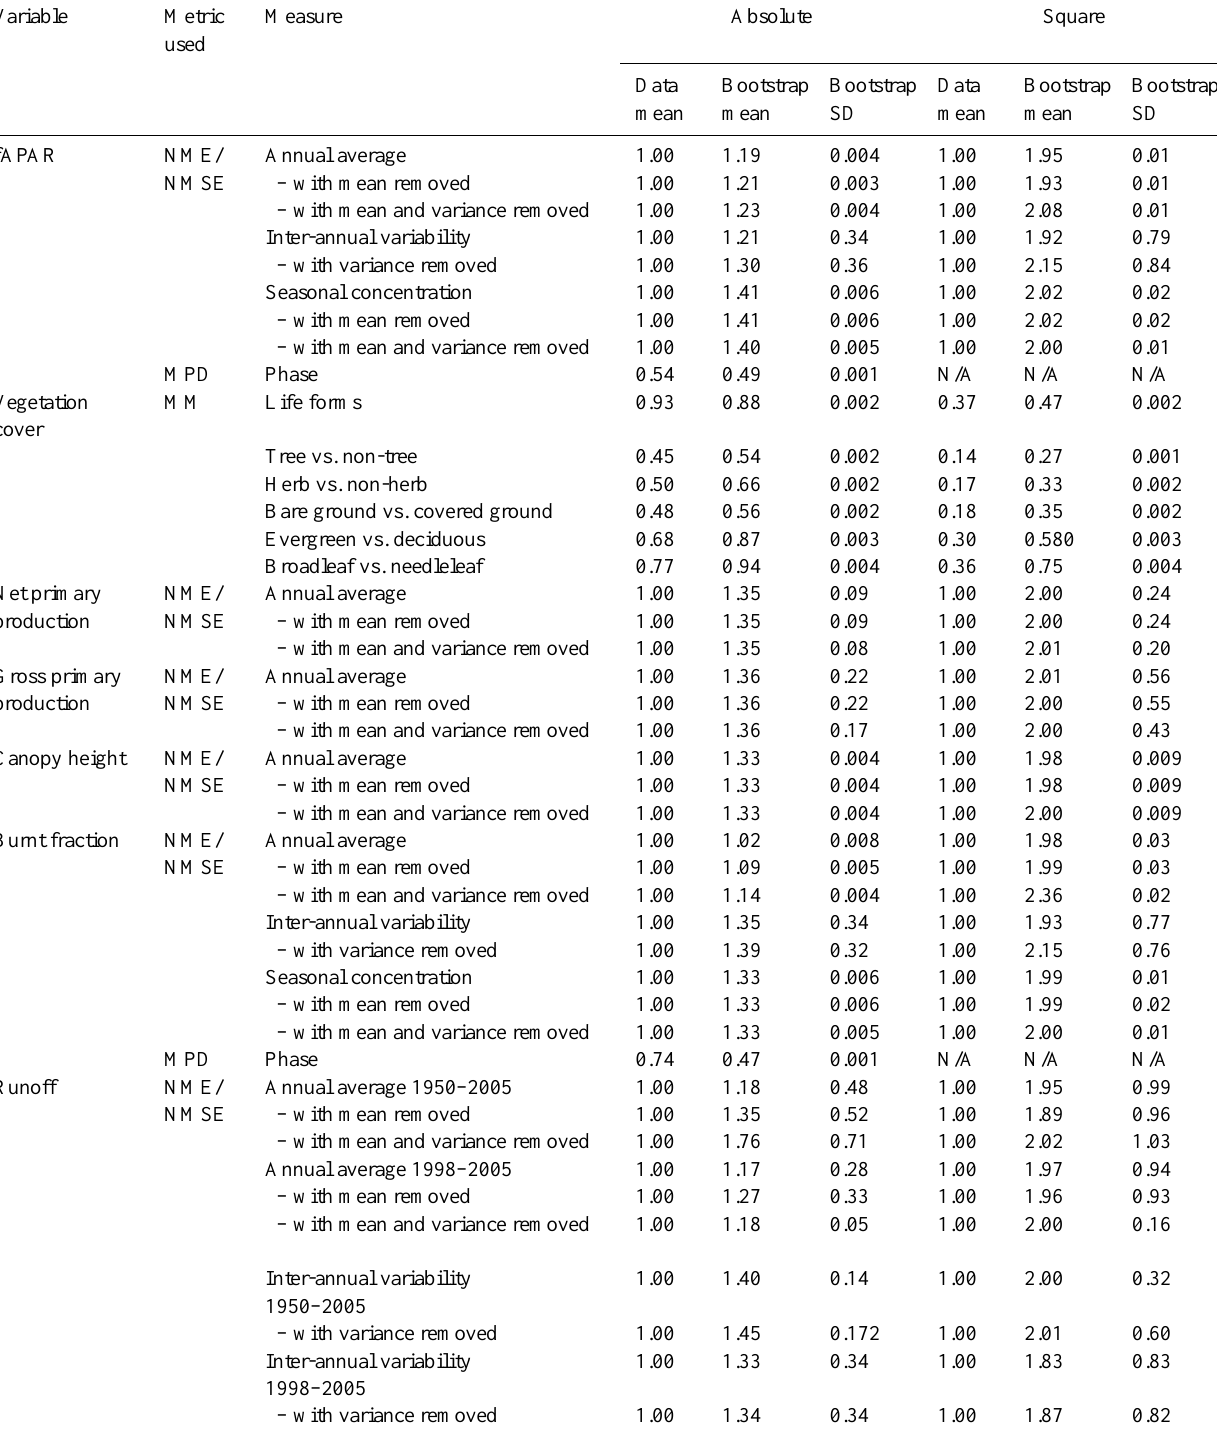
Table 4. Scores obtained using the mean of the data (Data mean), and the mean and standard deviation of the scores obtained from bootstrap- ping experiments (Bootstrap mean, Bootstrap SD). NME/NMSE denotes the normalised mean error/normalised mean squared error, MPD the mean phase difference and MM/SCD the Manhattan metric/squared chord distance